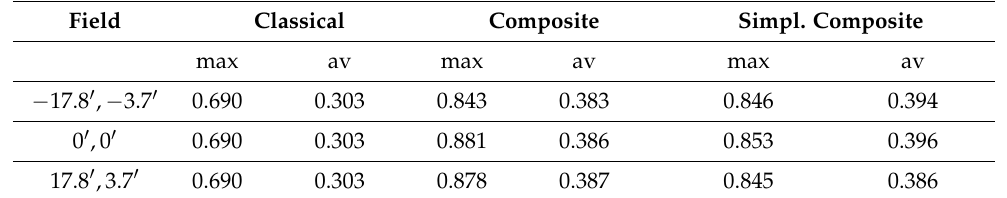
Table 5. Integral diffraction efficiency metrics.